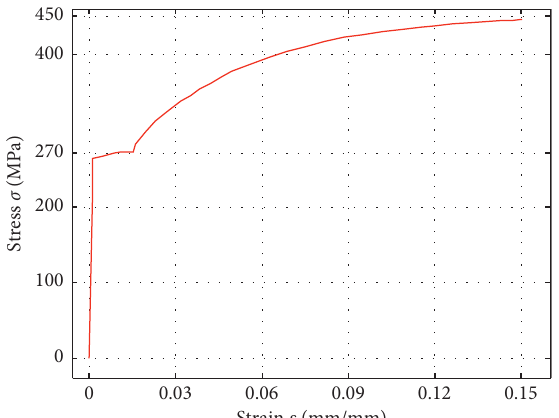
Figure 4: Experimental σ − ε curve under uniaxial tension for Q235